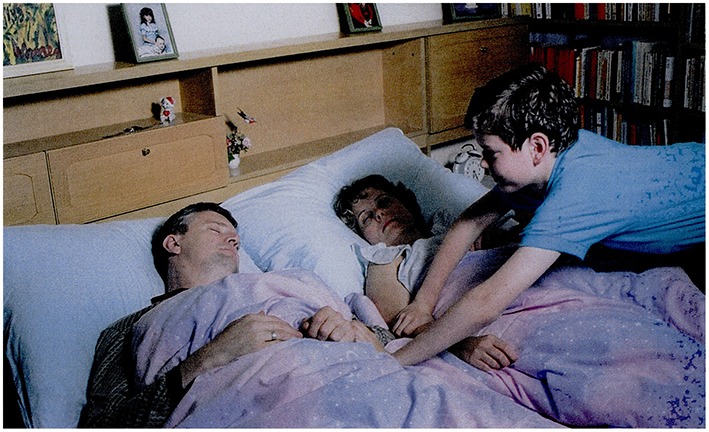
A boy is waking up his father (Stark, 1998).